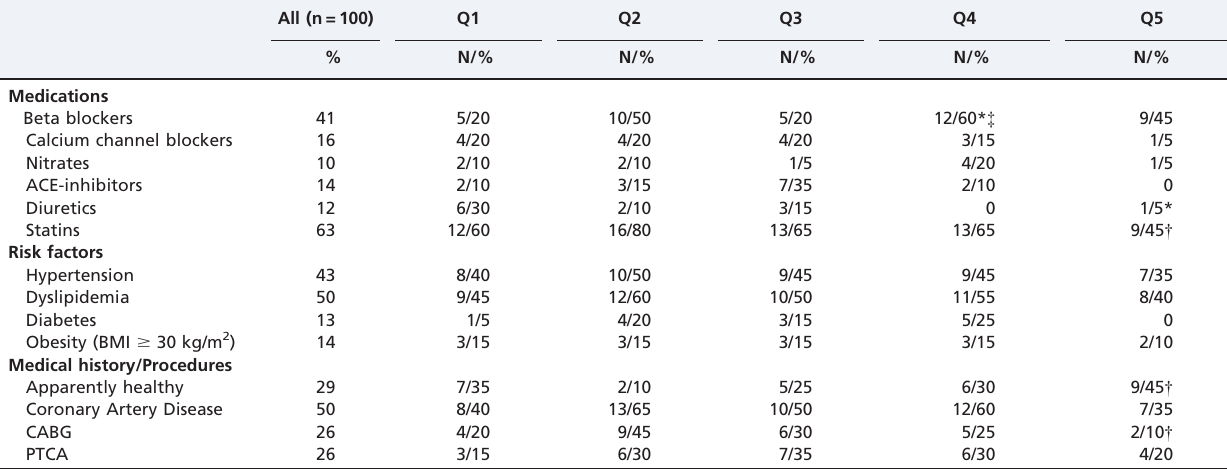
Table 1 - Baseline clinical characteristics by quintiles of maximum relative O 2